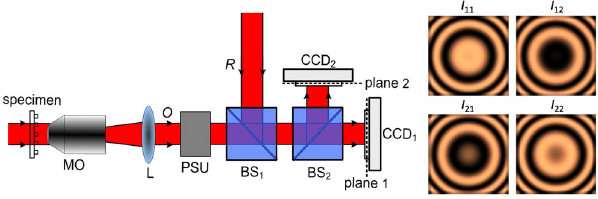
Figure 1. Configuration of TPD-DH in microscopy. plane 1 and plane 2 have a defocusing distance Δ z; MO , microscopic objective; L achromatic lens; CCD 1 , CCD 2 , CCD cameras; PSU, phase shifter unit; I 11 , I 12 , I 21 and I 22 are four interferograms for TPD-DH in